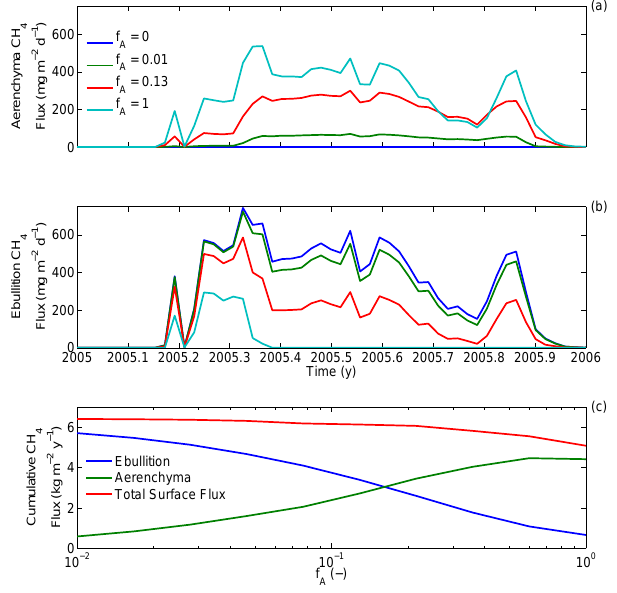
Fig. 7. (a) Predicted aerenchyma, (b) ebullition, and (c) cumulative CH 4 fluxes as a function of the fraction ( f A ) of total aerenchyma specific area for a gridcell corresponding to the Minnesota, USA site.